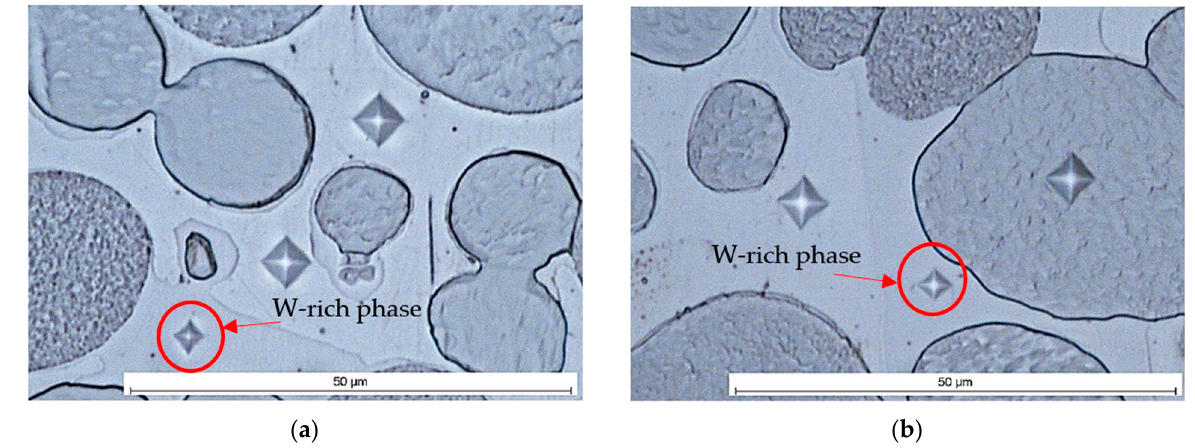
Figure 11. Comparison of indenter impressions in the sample WNi5Co5: ( a ) in the matrix and W-rich phase, ( b ) in the matrix, W-rich phase and tungsten grain (the indenter impression in the W-rich phase is marked with a red circle)